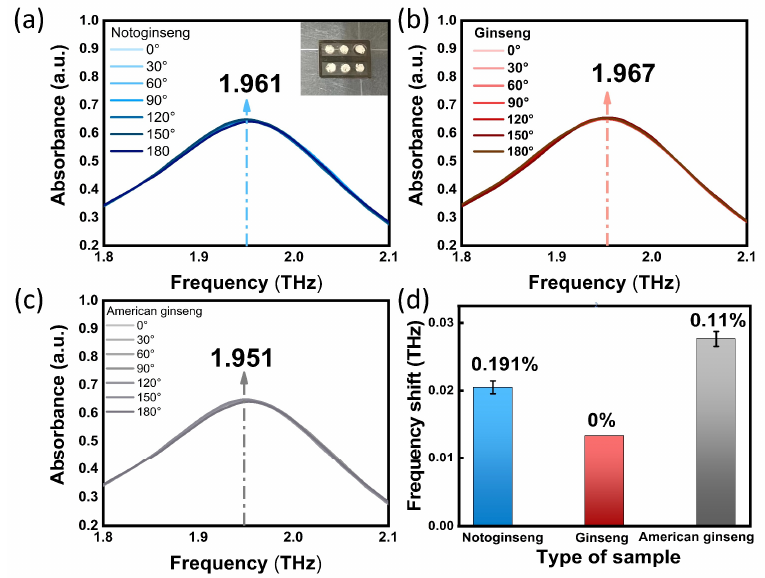
Figure 4. ( a – c ) Absorption spectra of biosensor with notoginseng, ginseng and American ginseng at different angles. The illustration in ( a ) shows an example of a biosensor divided into 6 areas on average. ( d ) Frequency shift changes of notoginseng, ginseng and American ginseng biosensors with angle